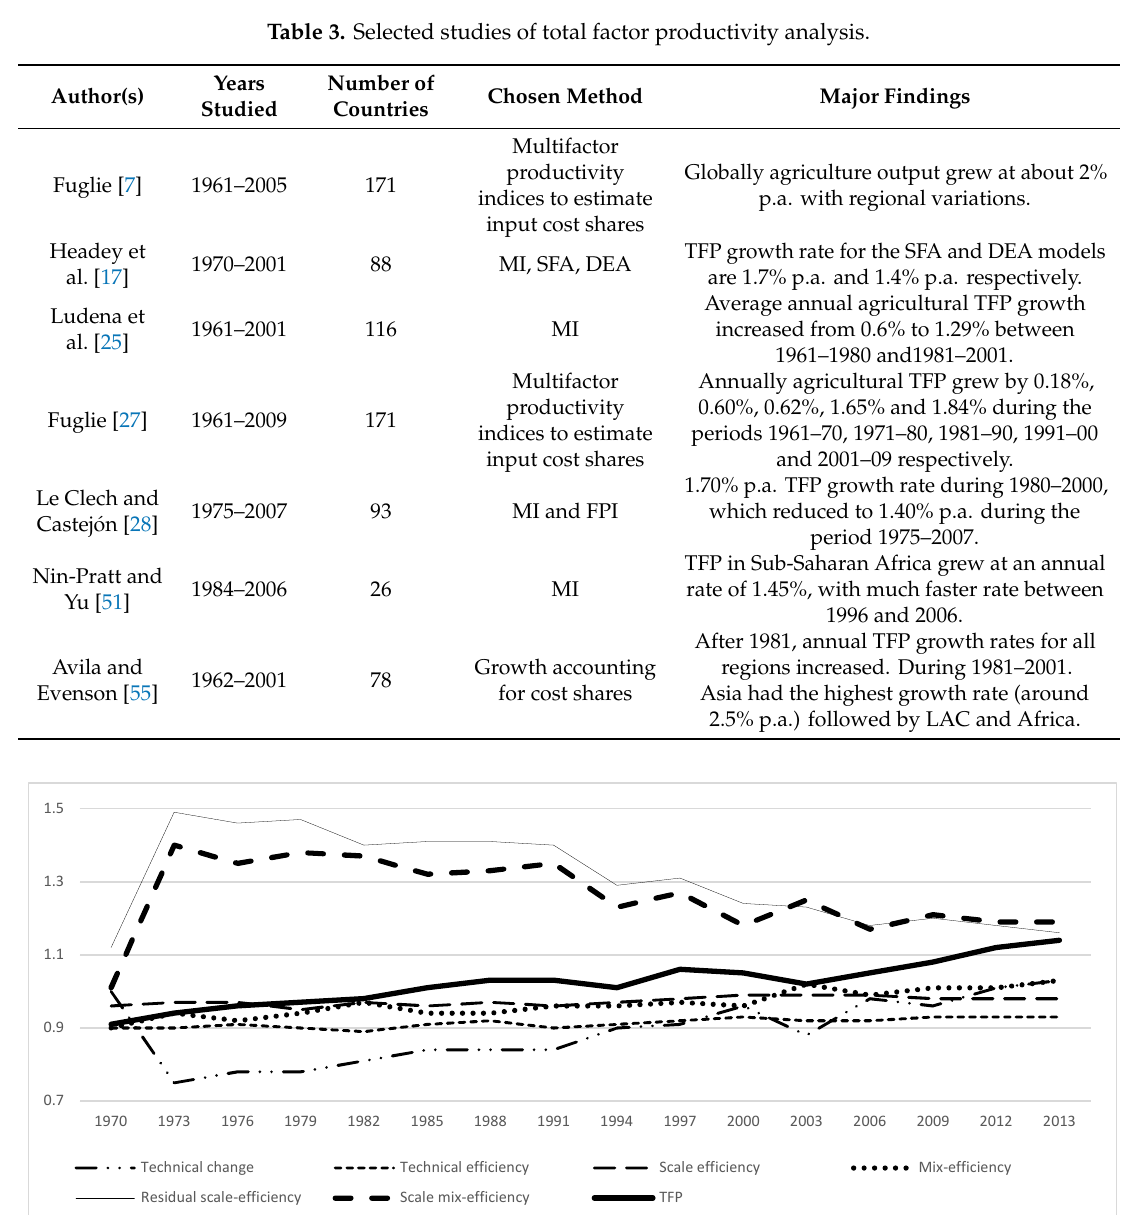
Figure 2. Global TFP change and its components during 1969–2013.